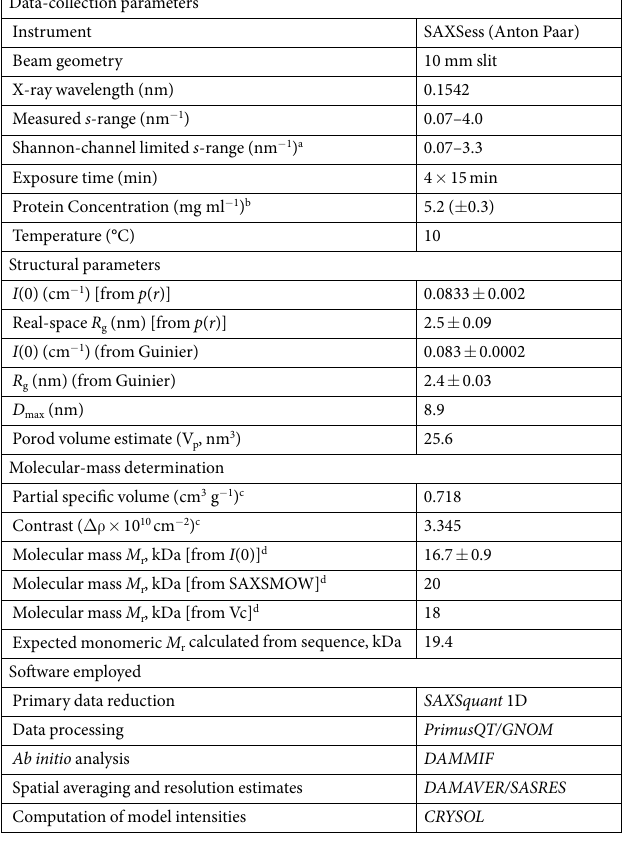
Table 1. Small angle scattering parameters for CEH-14–LIM-7. a The information content of the scattering data and corresponding s -range were evaluated using SHANUM 62 . b The protein concentration was determined at A 280 nm using the extinction coefficient calculated by ProtParam 59 from the primary amino acid sequence. c Obtained from the Contrast module of MULCH 61 . d Molecular mass estimates were determined from I (0) and protein concentration ( M r = I (0)N A /[protein]( Δρυ ) 2 ) as well as concentration-independent methods (SAXSMOW 32 and the volume of correlation, Vc 33